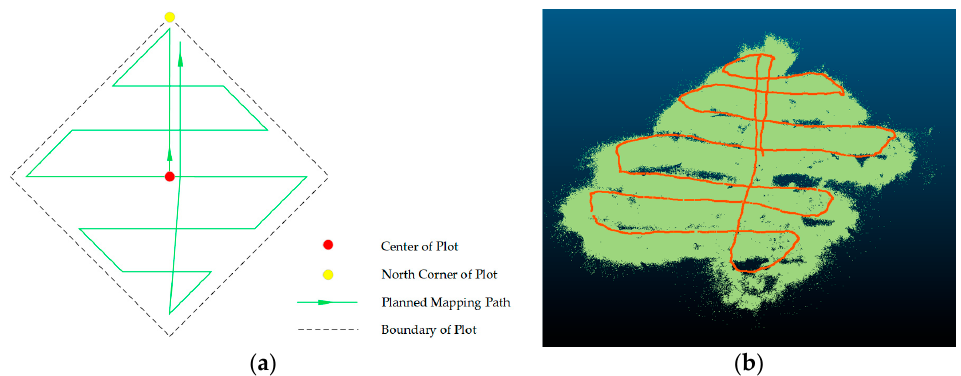
Figure 6. The mapping path of plot ground. ( a ) Pre-survey designed scan path map for collecting data with mobile phone; ( b ) Post-survey data collection, and actual path map.